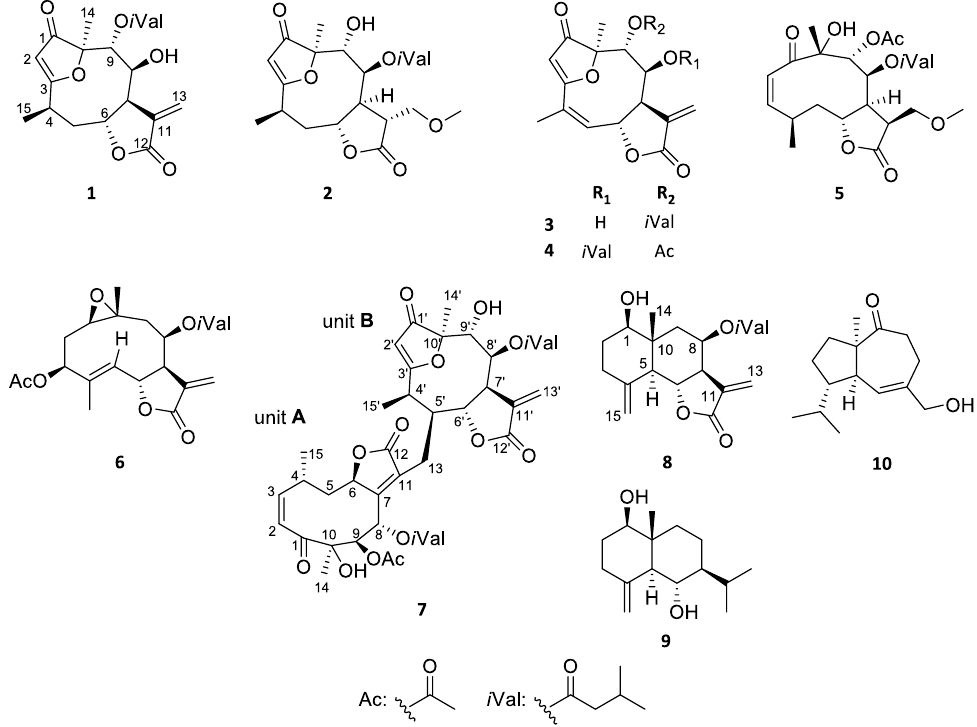
Figure 1. Structures of compounds 1 – 10 isolated from N. lobata . The absolute configuration of 1 was determined by the solution TDDFT-ECD method [35,36]. Merck Molecular Force Field (MMFF) conformational search of (4 R ,6 R ,7 R ,8 S ,9 R ,10 R )- 1 resulted in 133 initial conformers in a 21 kJ/mol energy window. These structures were re-optimized at the CAM-B3LYP/TZVP [37] PCM/MeCN levels yielding 12 low-energy conformers over 1% Boltzmann population. ECD spectra computed at various levels of theory for these conformers reproduced well the experimental ECD spectrum (Figure 2). Further- more, the low-energy conformers, differing only in the orientation of the Oi Val and the OH groups (Figure 3), gave similar computed ECD spectra allowing the solid elucida- tion of the absolute configuration as (4 R ,6 R ,7 R ,8 S ,9 R ,10 R )- 1 . To test the applicability of the DFT-NMR method [28,38], the 133 MMFF conformers were also re-optimized at the B3LYP/6-31+G(d,p) level yielding seven low-energy conformers. The NMR shift values were computed for these conformers both at the mPW1PW91/6-311+G(2d,p) and the mPW1PW91/6-311+G(2d,p) SMD/CDCl 3 levels [39]. Computed and experimental 13 C NMR chemical shift values gave a good overall agreement with CMAE (corrected mean absolute error) values [40] of 1.92 and 1.77 ppm, respectively (Table S1). Although the 13 C NMR DFT calculation showed good agreement for compound 1 , the exomethylene group caused larger deviations in the computed NMR shift values [41,42] of the other derivatives of this work even by testing at different levels of